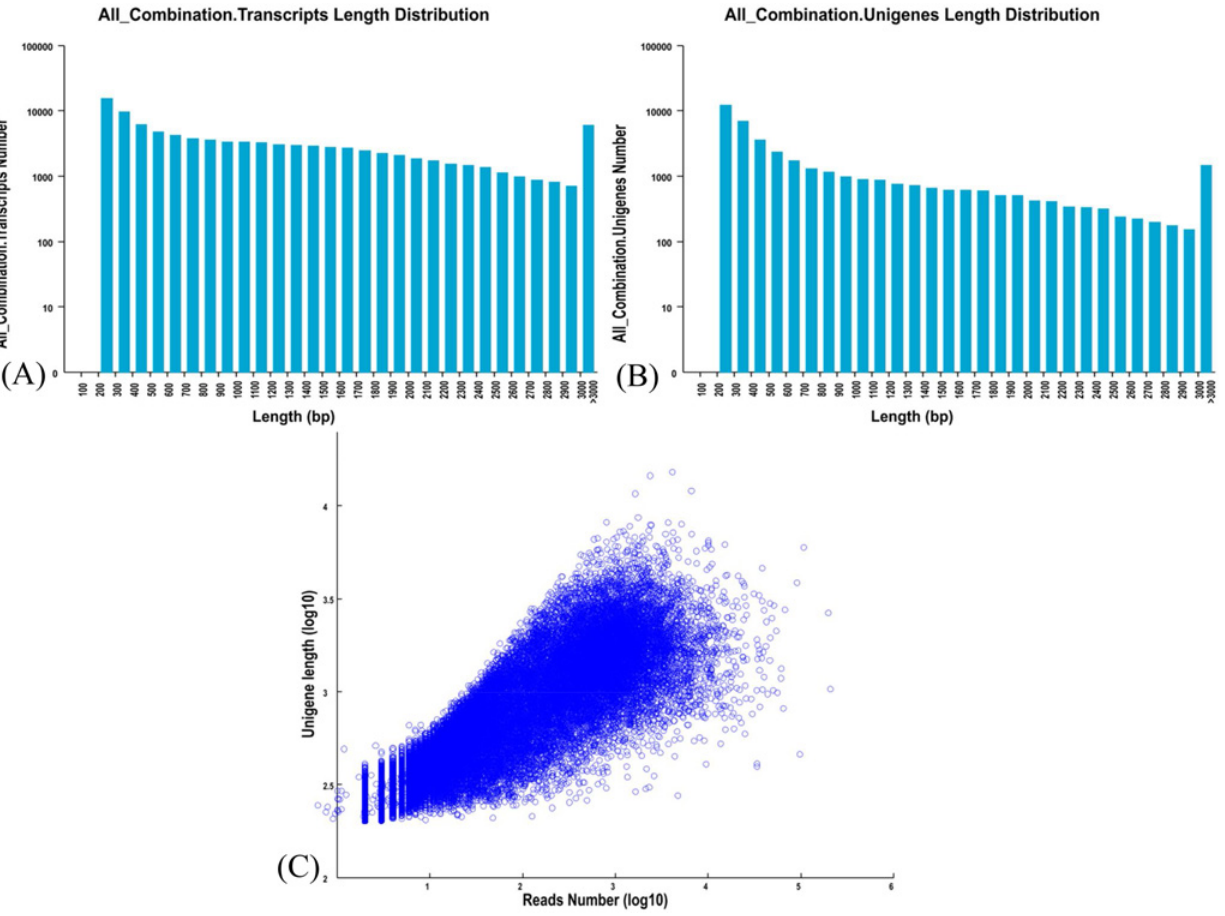
Fig 1. Overview of the A . comosus var. bracteatus transcriptome sequencing and assembly. (A) Length distribution of A . comosus var. bracteatus transcripts. (B) Size distribution of A . comosus var. bracteatus unigenes. (C) Log-log plot showing the dependence of unigene lengths on the number of reads assembled into each